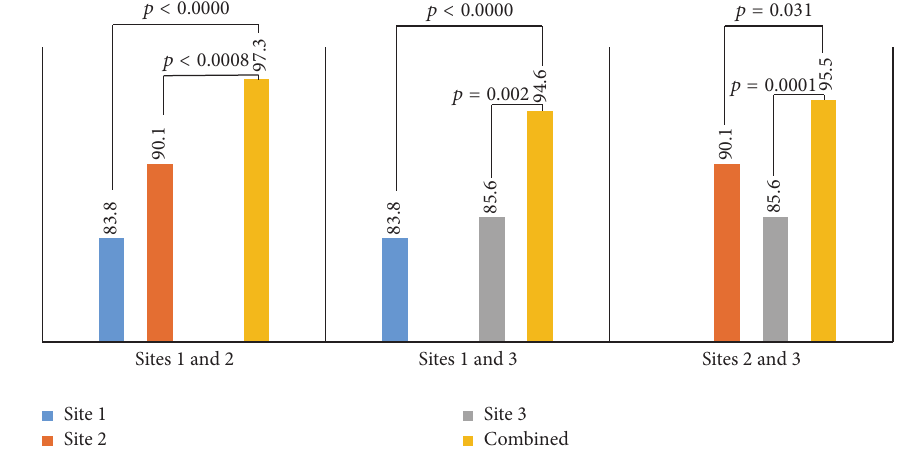
Figure 2: RUT results from single specimen versus combined specimens from two biopsy